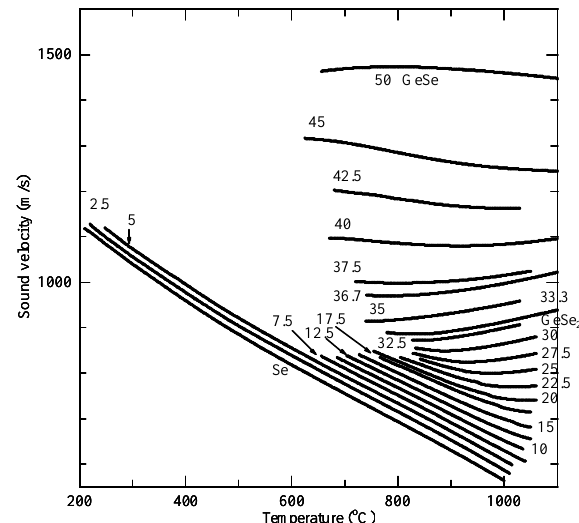
Fig. 1. Sound velocity in the liquid Se-SeGe alloy. Numbers are at.% of